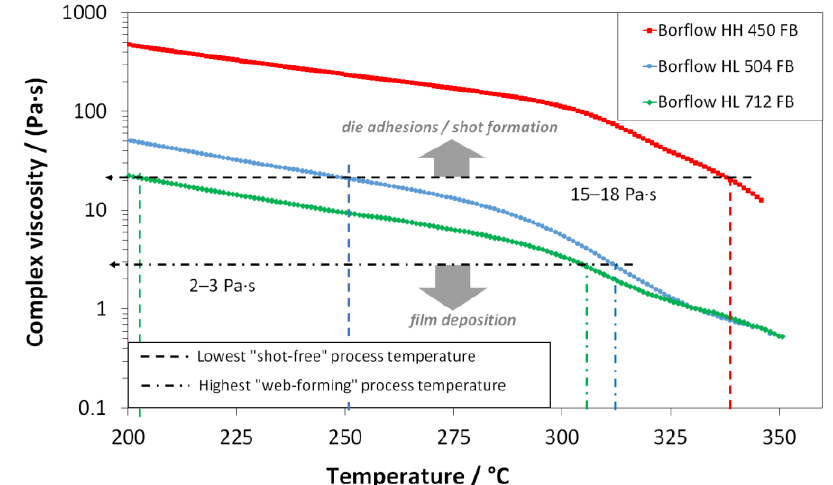
Figure 3. Shear rheological temperature sweeps (ω = 10 rad ꞏ s −1 , ε = 10%, 𝑇̇ = 0.5 K ꞏ min −1 ) of three polypropylene types (red: HH450FB; blue: HL504FB; black: HL712FB) and onset temperatures of process limitations (dotted line: min. process temperature; dot-line-dot: max. process temperature); the related plots of the storage- and loss modulus are given in the supplementary materials (see Supplementary Materials Figure S1).